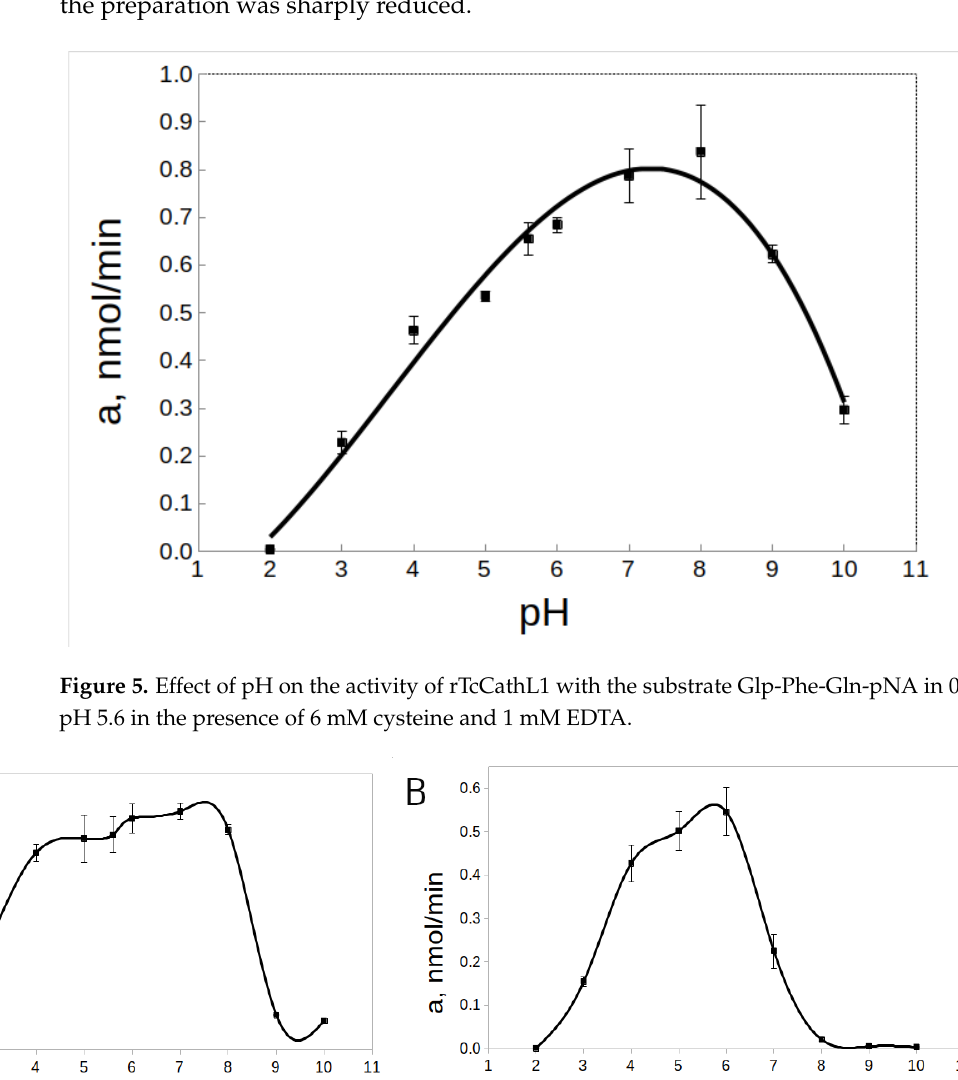
Figure 4. MS analysis of rpTcCathL1 and rTcCathL1. Peptides identified by peptide fingerprinting using matrix-assisted laser desorption/ionization time of flight mass spectrometry (MALDI-TOF MS) are marked in red; peptides sequenced by MS/MS analysis are underlined; amino acid residues